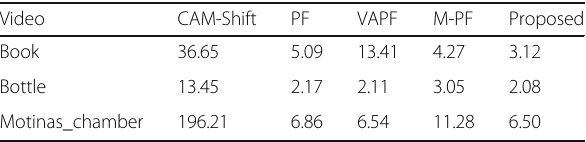
Table 7 Resulting of averaged width error Video